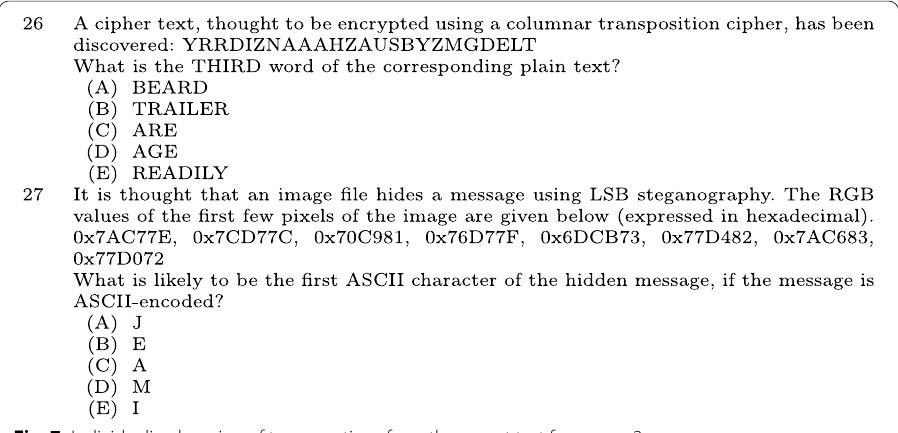
Fig. 7 Individualized version of two questions from the repeat test for course